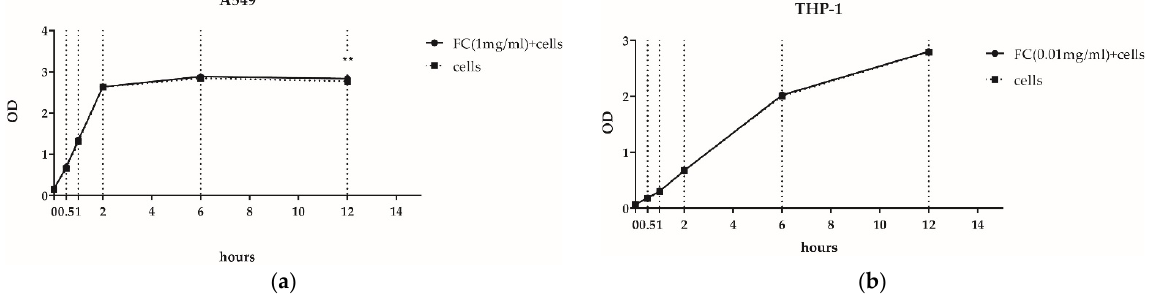
Figure 1. Cell proliferation assays with the CCK8 method in 12 h. (The error bars are shorter than the height of the dots here.) ( a ) A549 cells; ( b ) THP-1 cells. ** p < 0.01.